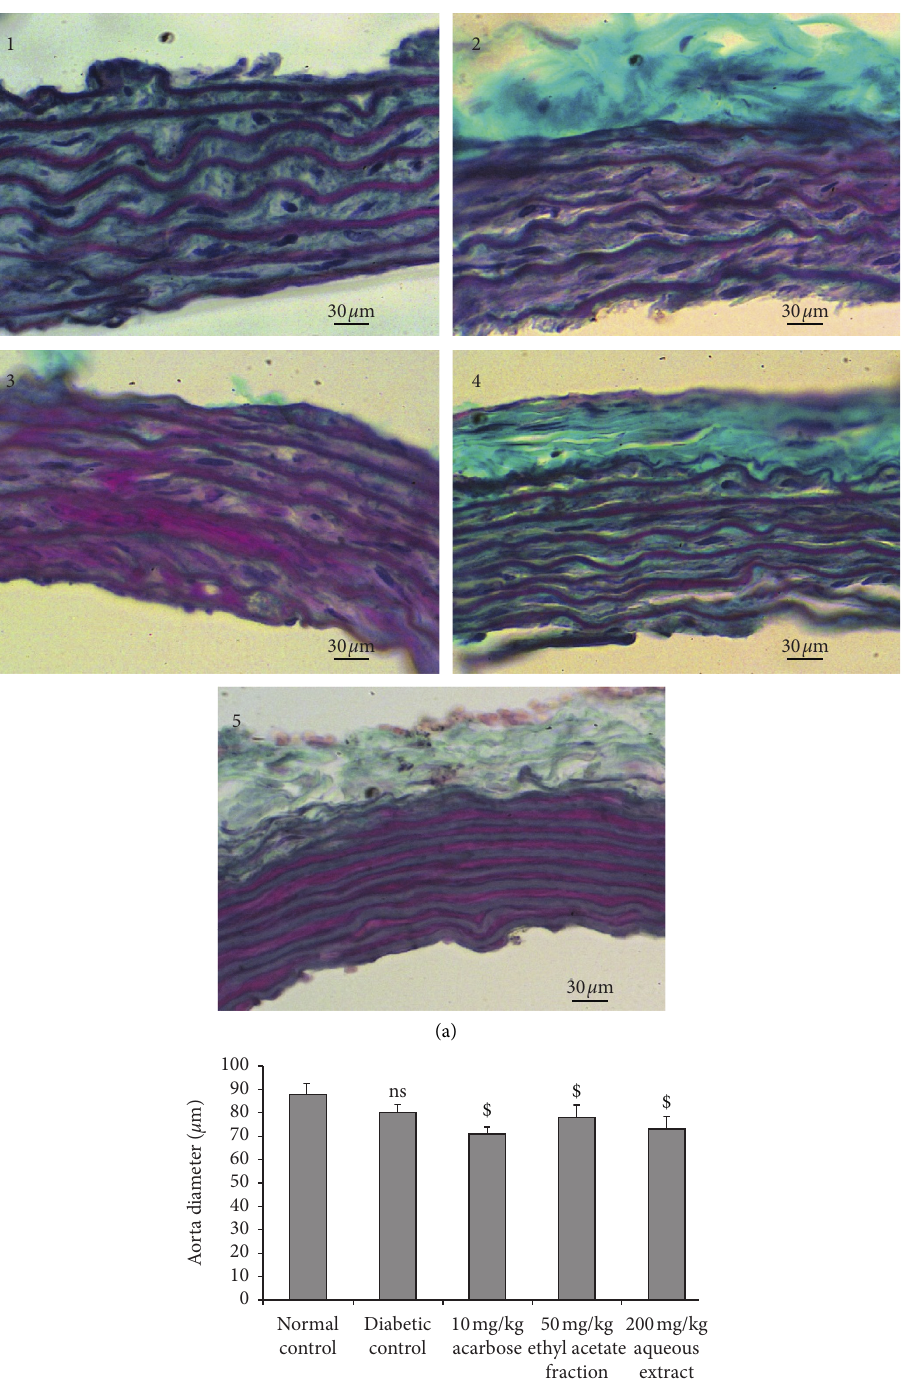
Figure 6: Effect of 200mg/kg AqTh, 50mg/kg EaTh, and 10 mg/kg acarbose treatment on aorta diameter of STZ-induced diabetic rats after 4-week treatment. (a) Histological appearance of aorta tissue in normal (1), diabetic (2), AqTh-treated (3), EaTh-treated (4), and acarbose- treated rats (5). (b) Aorta diameter. Sections were stained in Masson’s trichrome and observed in light microscope (original magnification × 400). Each value represents the means ± SEM. n � 5-6. ns p > 0 . 05 compared to the normal group. $ p > 0 . 05 compared to the diabetic